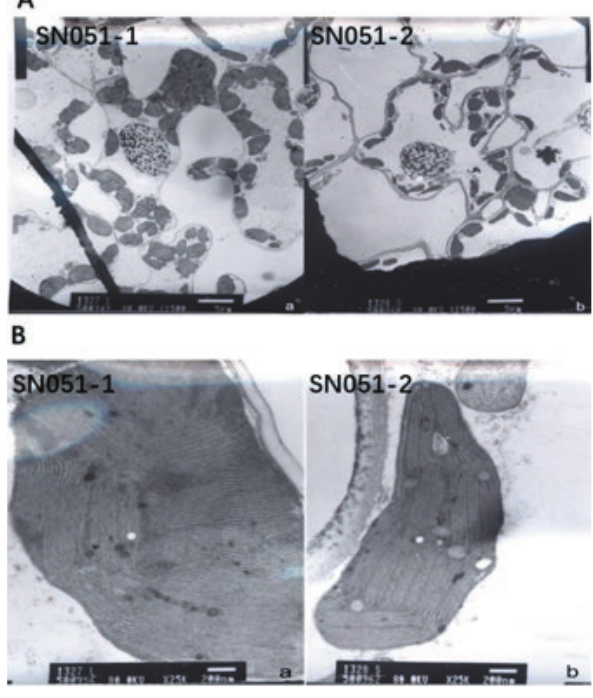
Figure 5. Ultrastructure and TEM results of chloroplast. A. Ultra- structure of chloroplast in SN051-1 awn cells b ultrastructure of chloroplast in SN051-1awn cells. The chloroplast in SN051-1 awn cells was bigger and more than that in SN051-2. B. TEM images show the ultrastructure of a single chloroplast in awns. An ultra- structure of single chloroplast in SN051-1 awn cell b ultrastruc- ture of single chloroplast in SN051-1 awn cell. The chloroplast in SN051-1 awn cell was bigger than that in SN051-2.